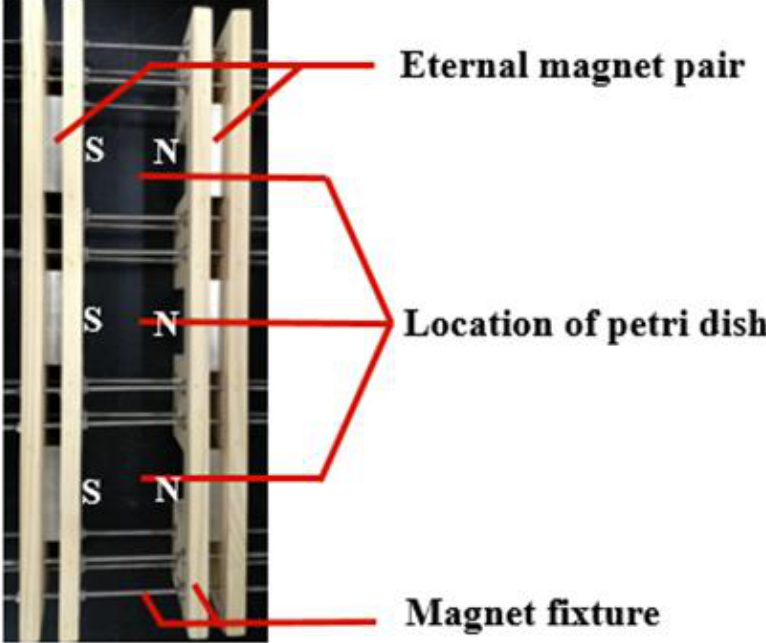
Figure 1. The device of static magnetic field produced by a pair of permanent magnets [30].